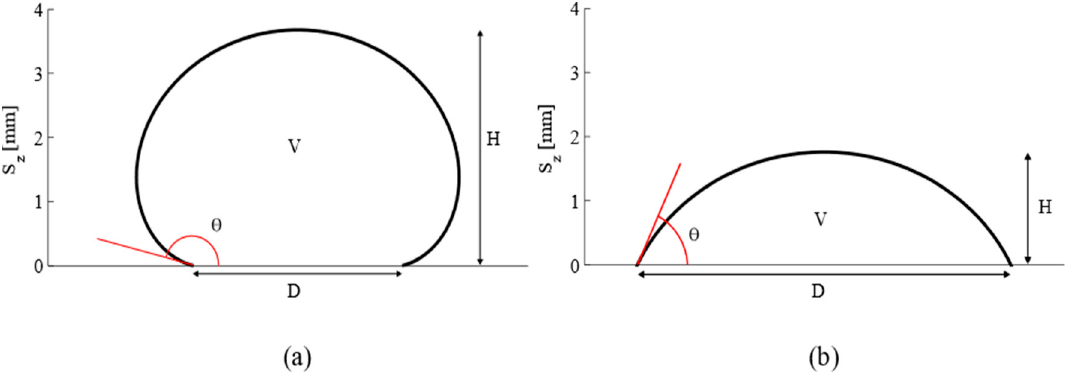
Figure 2. Droplet schematic and parameters: ( a ) hydrophobic droplet and ( b ) hydrophilic